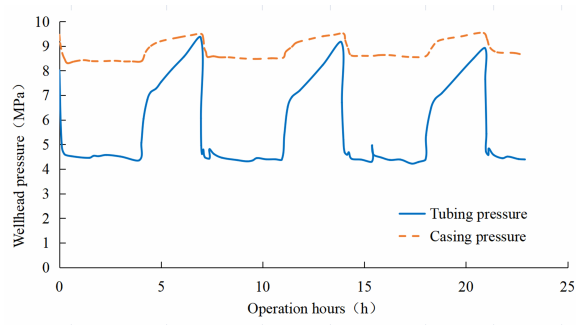
Fig. 19. Plunger running